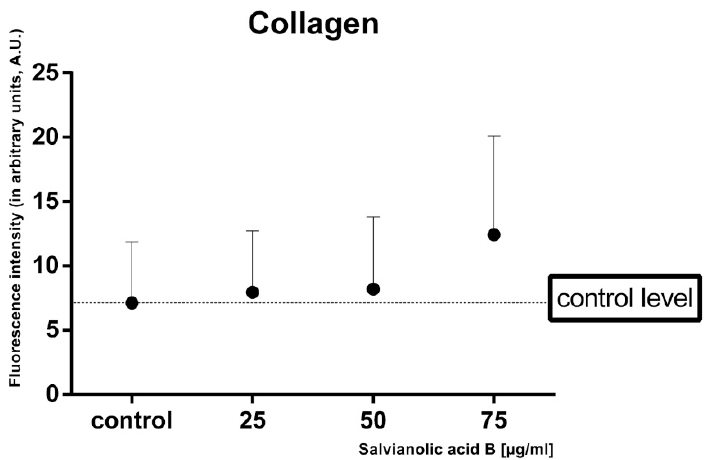
Figure 5. Intensity of fluorescence of collagen type III in fibroblasts in arbitrary units.